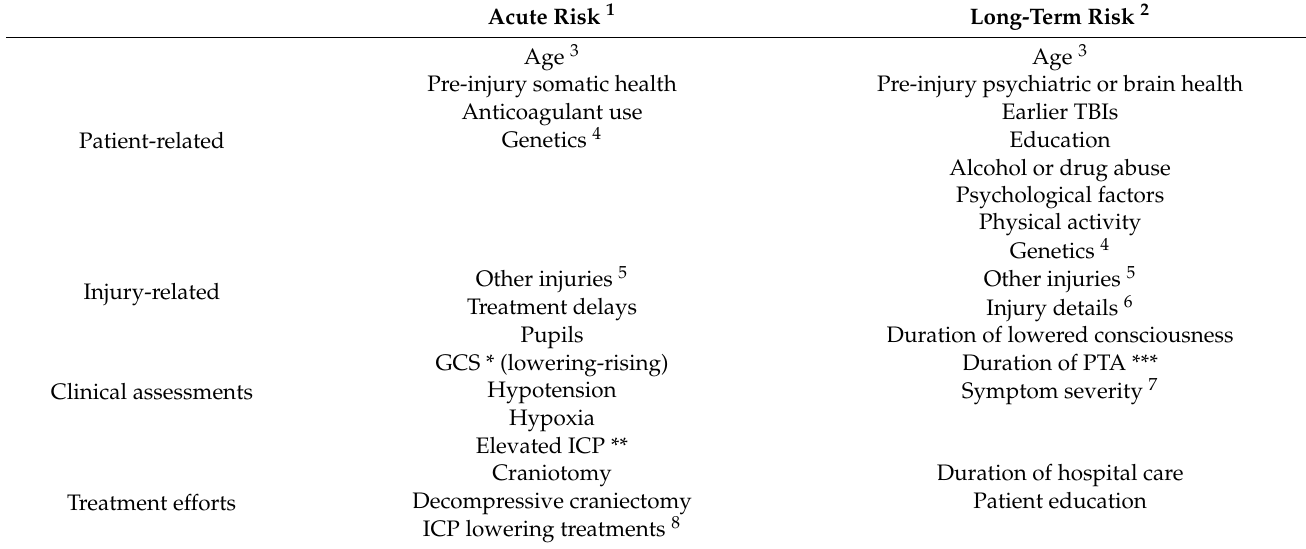
Table 4. An outline for new risk based TBI classification. The risks depend on the time from injury and available data. Acute Risk